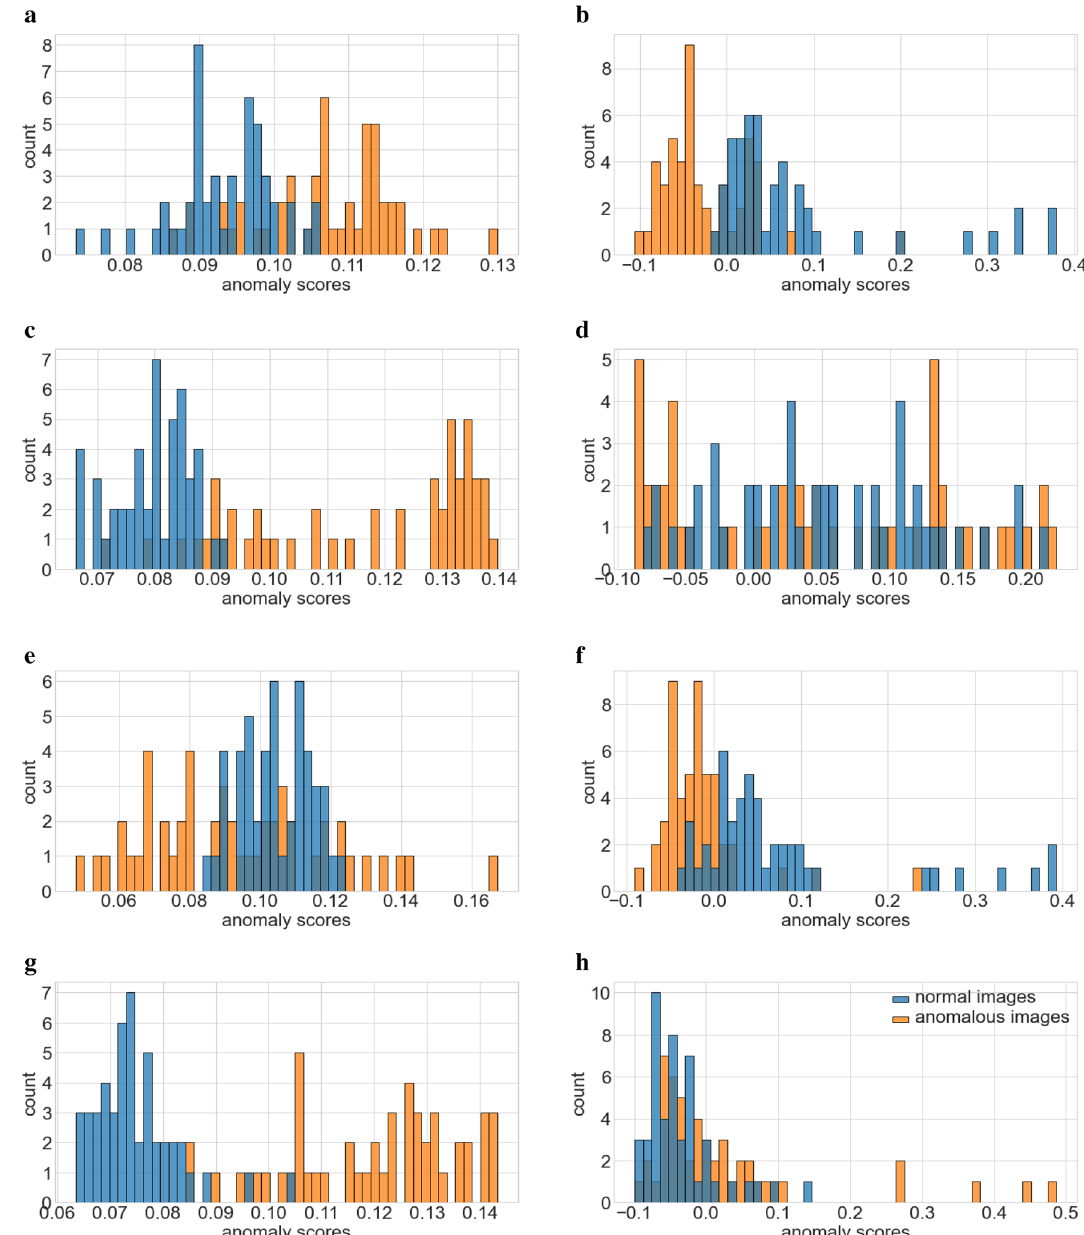
for the reconstruction error approach for model 3, f for the bottle- neck-values approach for model 3, g for the reconstruction error approach for model 4, h for the bottleneck-values approach for model 4